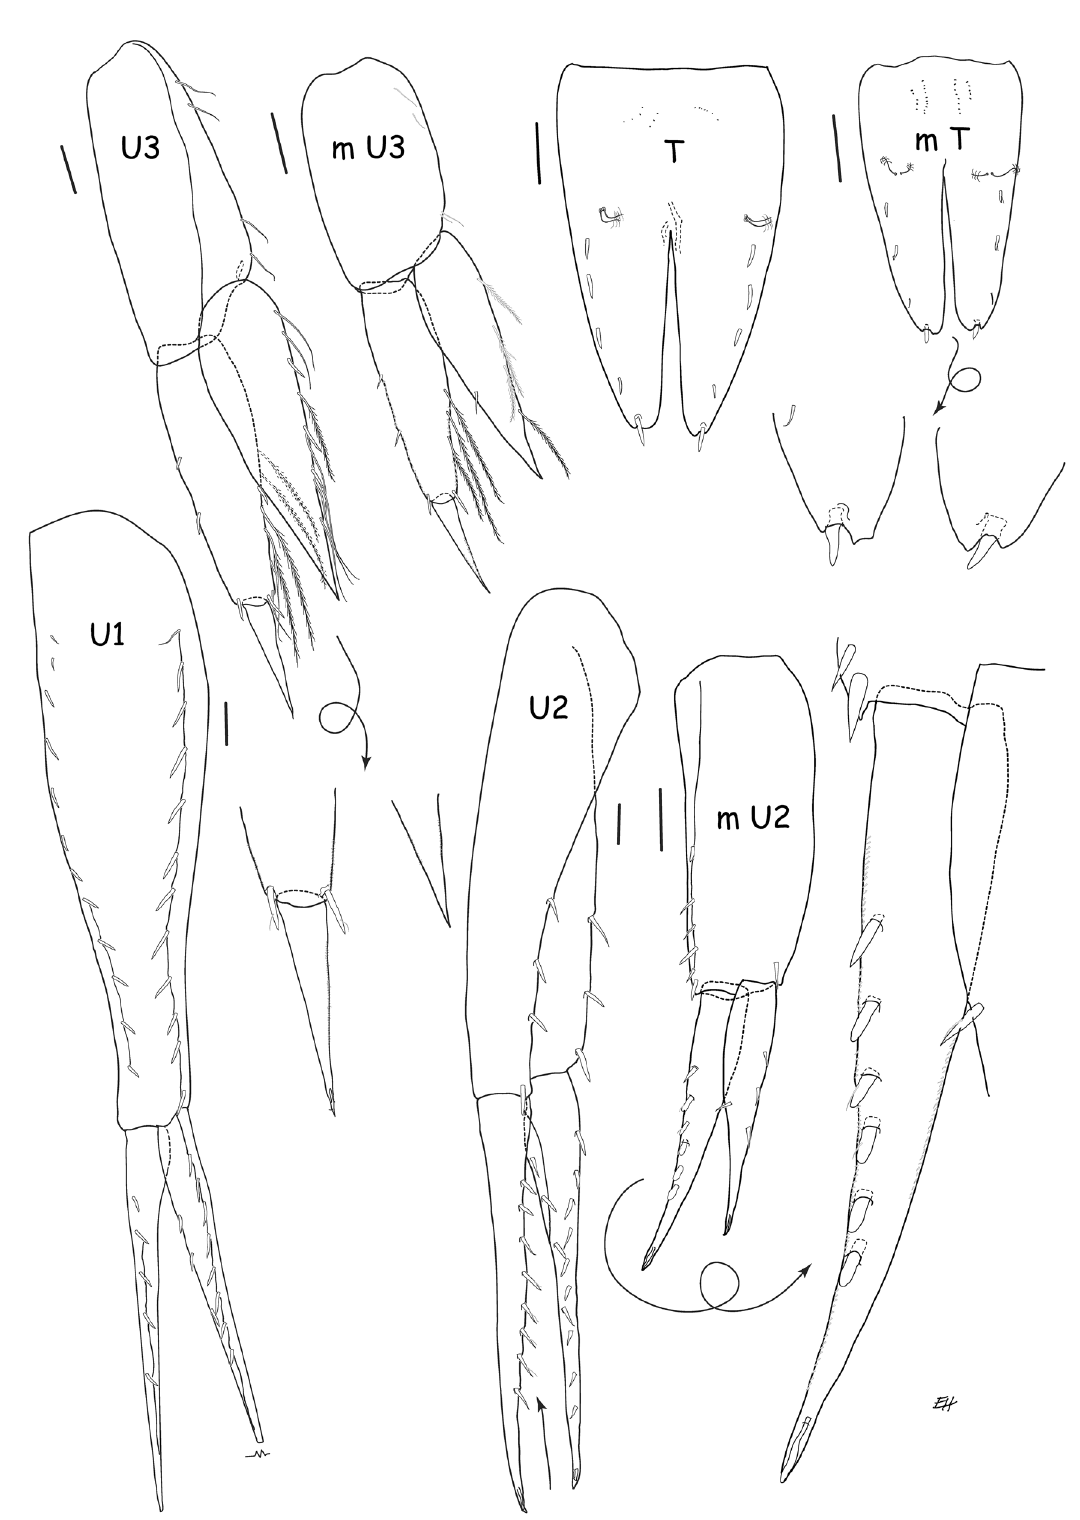
Fig. 33. Abyssorchomene shannonae sp. nov., holotype, ♀, 12 mm (ZMH K-61209); allotype, ♂, 7 mm (ZMH K-61210). Outer ramus is oriented on the left side of the uropods. Figures with sex not indicated are of female. Scale bars = 0.1